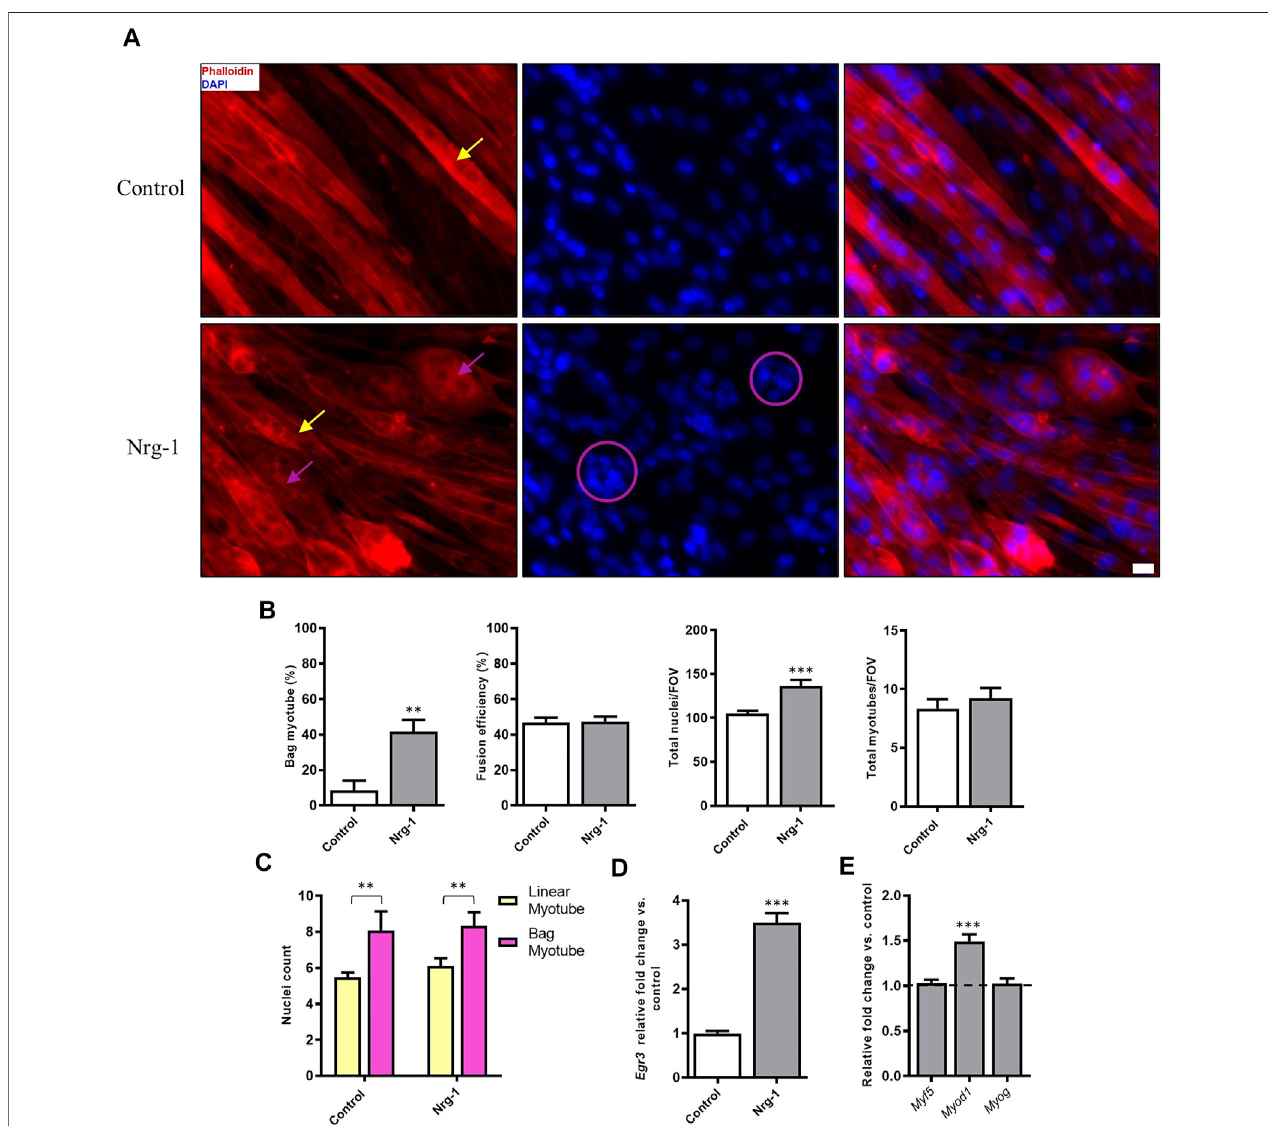
FIGURE3| Nrg-1treatmentcauses asigni fi cantincreaseinbag myotubeformationandnucleinumberinC2C12 myotubes. (A) Highmagni fi cationrepresentative fl uorescentmicrographsofcells ± Nrg-1usedforquanti fi cation.Phalloidin(red)andDAPI(blue),yellowarrowspointtowardmyotubeswithlinearmorphologyandpurple arrows toward bag morphology (Scale bar, 20 µm). (B) Comparison of key morphological criteria between myotubes ± Nrg-1. (C) Nuclei counts within bag and linear myotubes and ± Nrg-1. Control-Linear -60 myotubes, Control-Bag- 11 myotubes, Nrg-1-Linear - 40 myotubes, Nrg-1-Bag -33myotubes. (D) qRT-PCR analysis of Egr3 expression. (E) qRT-PCR analysis of MRFs following Nrg-1 treatment vs. control. Control values are not shown and are represented by the dotted line at 1.0. Mean ± SEM, n (cid:1) 9, ** p < 0.01, *** p < 0.001.